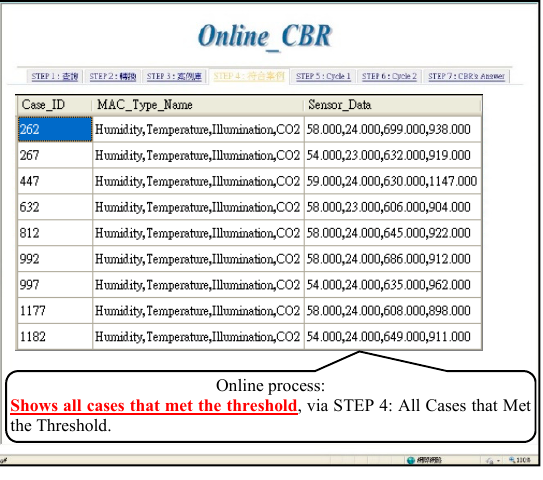
Figure 16. All cases that met the threshold.